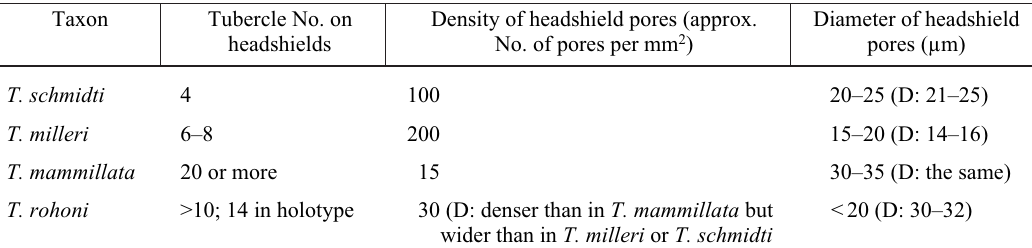
Table 1. Measurements of pores in the headshields of the holotypes of four Tremataspis species from Estonia (Märss et al. 2014; D: taken from Denison